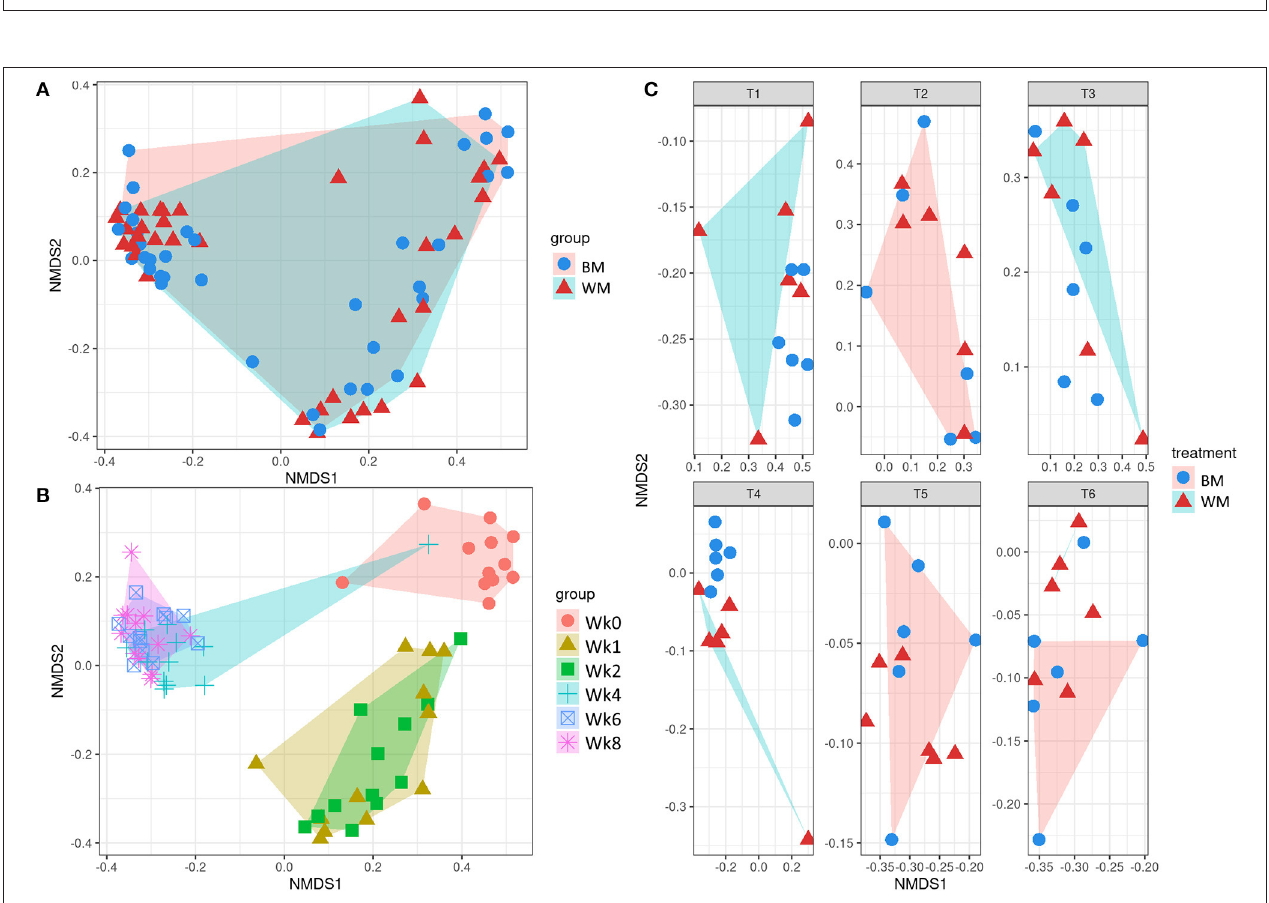
FIGURE 3 | Beta diversity according to treatment (A) , time point (B) , and treatment-by-time point (C) . The legends indicate the color codes and symbols used for the different sample groups [blue circles and pink shading, bulk tank milk (BM); red triangles and turquoise shading, waste milk (WM)] and time points (pink circle, Wk0; brown triangle, Wk1; green square, Wk2; turquoise cross, Wk4; blue box, Wk6; pink asterisk, Wk8).